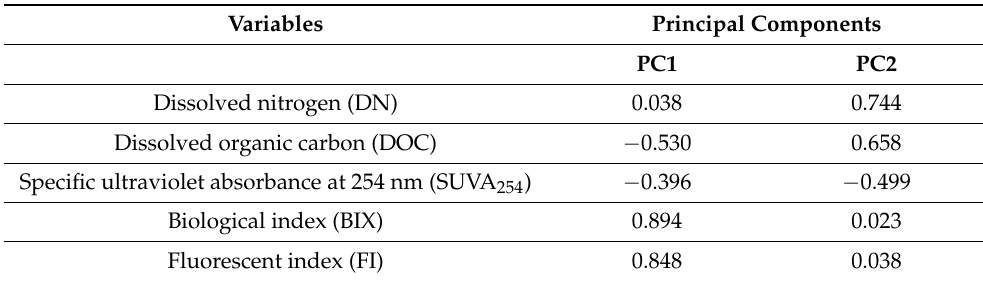
Table 3. Rotated component matrix showing the structure loading matrix correlation between the studied variables and the principal components